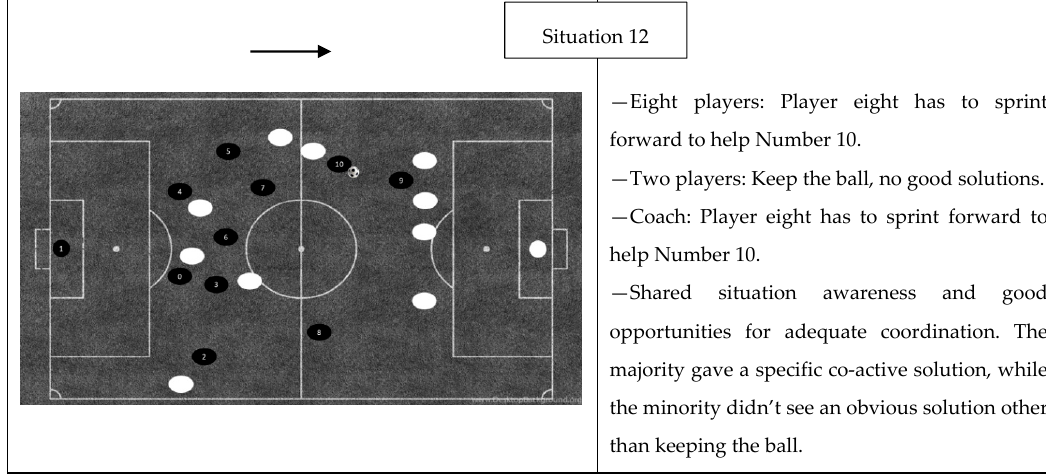
Figure 2. Offensive situations and the distribution of player responses in categories. Players with numbers represent the inquired team and the arrow specifies the attacking direction. Player 0 is the player that did not participate in the study.